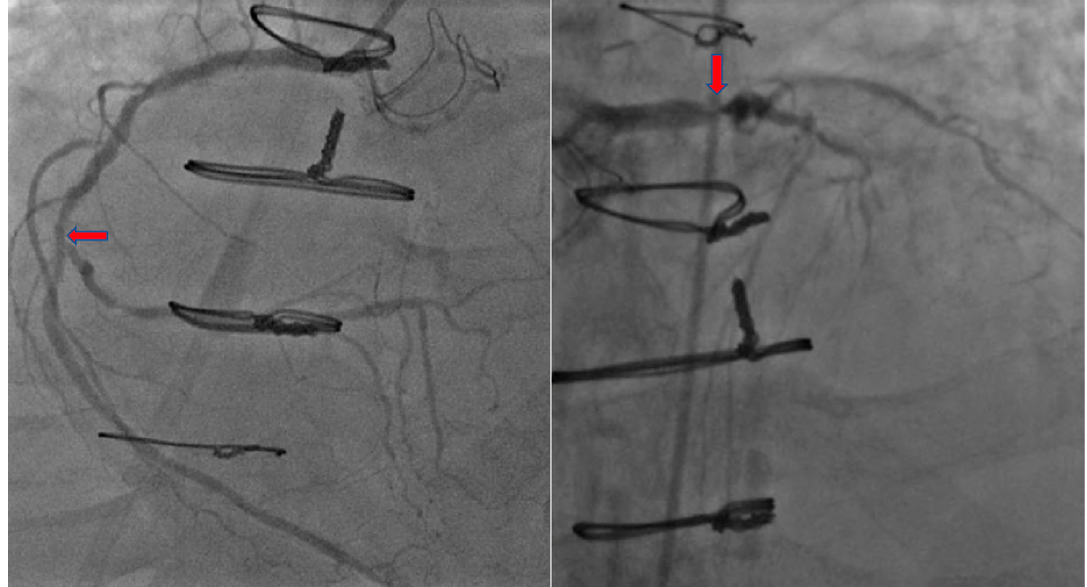
Figure 1. Coronary Angiography of right coronary artery (left) and left coronary artery (right).